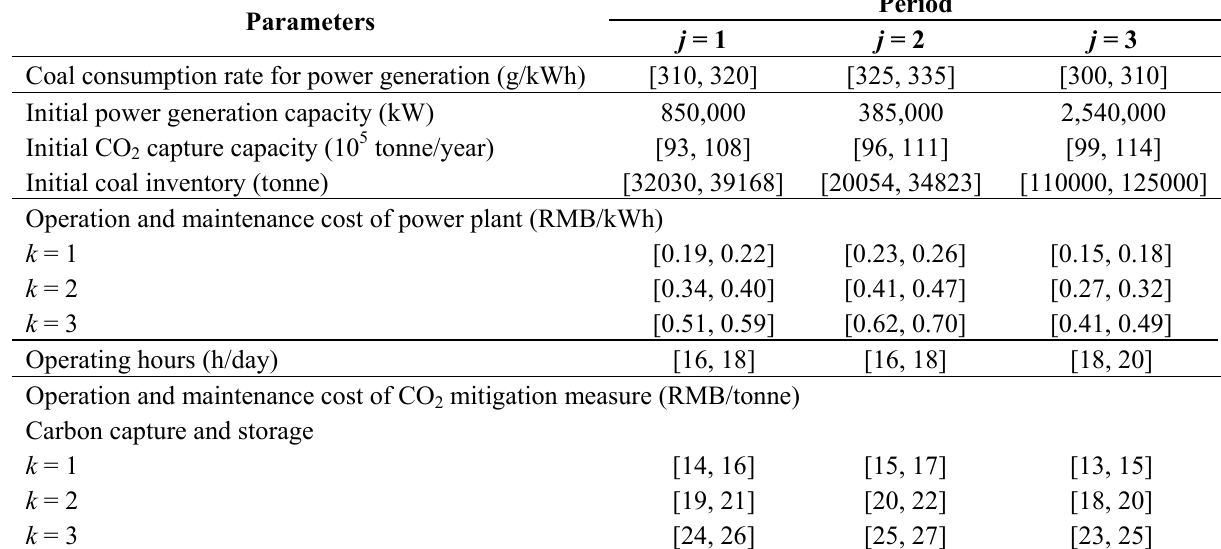
Table 3. Basic parameters of the